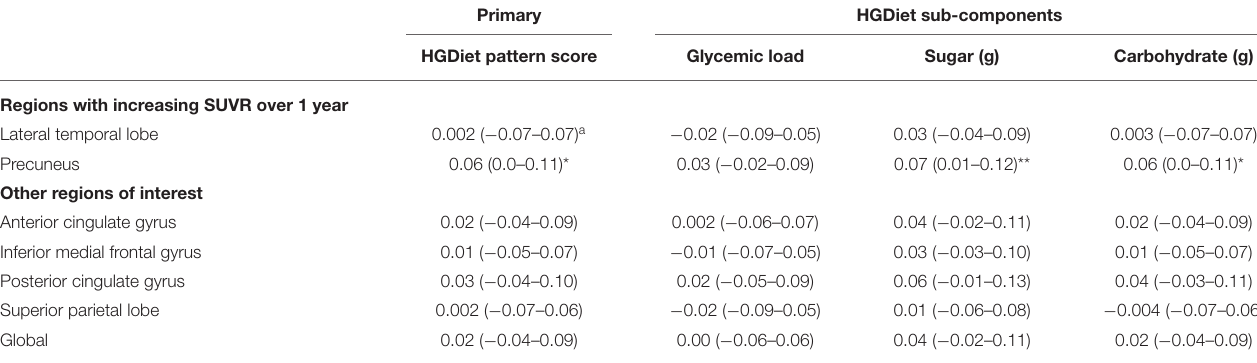
TABLE 2 | Relationship between high glycemic diet measures and regional change in cerebral amyloid burden among all participants a